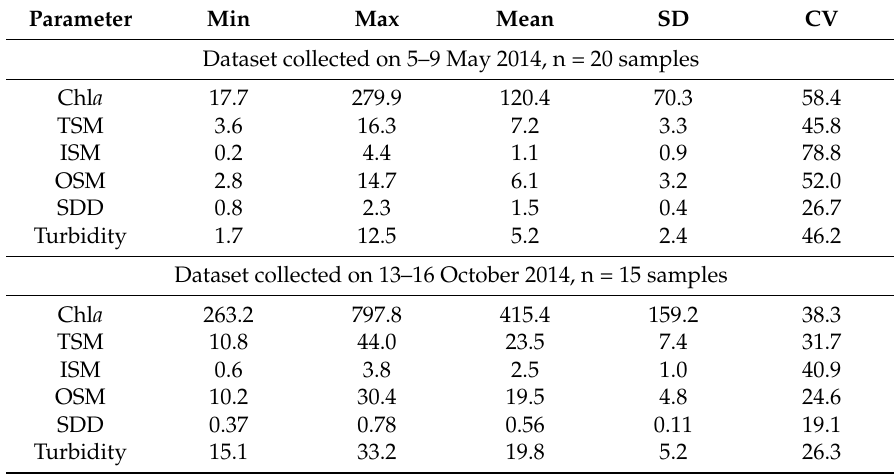
Table 1. Descriptive statistics of water quality optical parameters: chl a (mg m − 3 ), TSM, inorganic suspended matter (ISM), and organic suspended matter (OSM) (g m − 3 ), Secchi disk depth (SDD) (m) and turbidity (NTU) collected in May and October 2014. Statistics metrics used: minimum value (Min), maximum value (Max), mean, standard deviation (SD), and coefficient of variation (CV = (SD/mean) × 100)